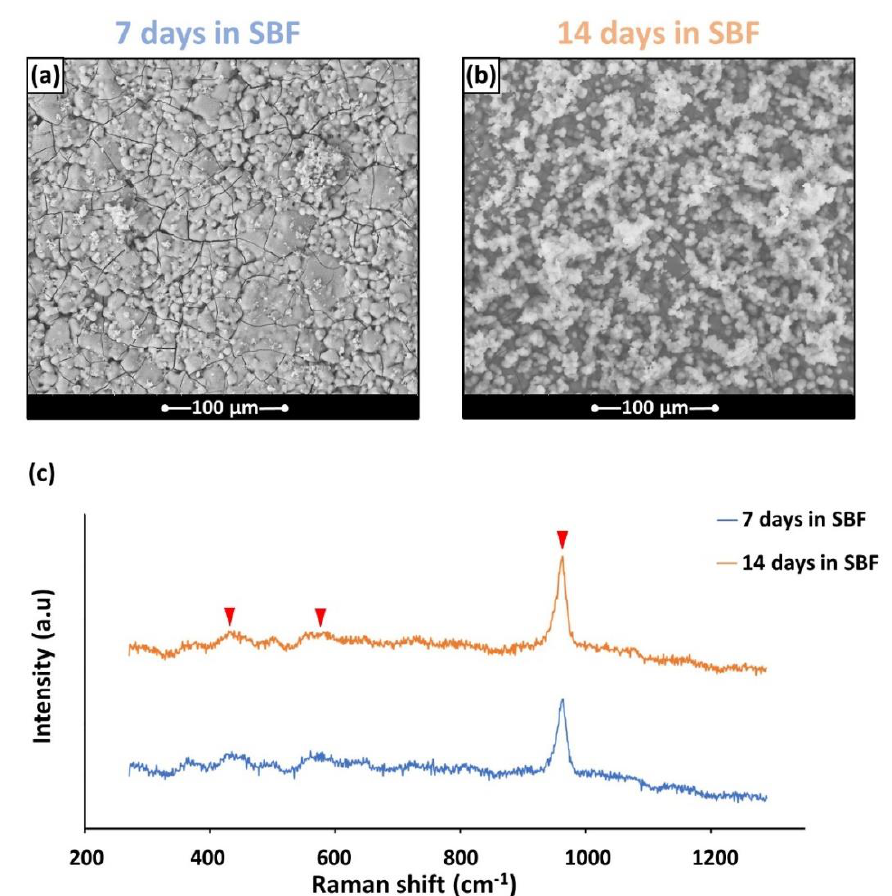
Figure 3. ( a , b ) The HA formation on BGMS_LS samples after soaking in SBF; ( c ) typical Raman spectra acquired on the HA precipitates. The arrows indicate the main peaks of HA.